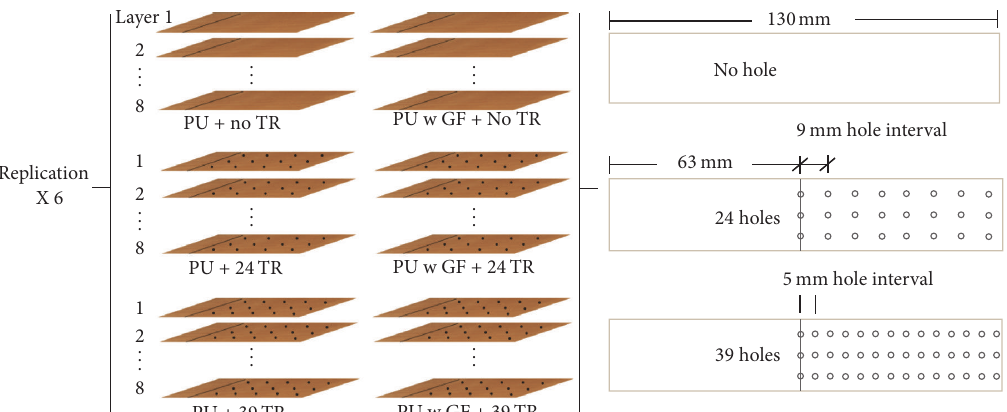
Figure 1: Preparation of laminated birch wood composite specimens with two levels of through-reinforcement (TR) of laminae and polyurethane (PU) adhesive bond reinforcement with glass-fibre